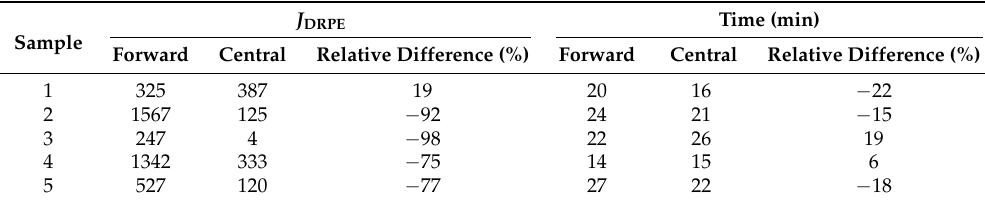
Table 9. Averaged results of objective function values and computational cost for different samples according to the type of finite